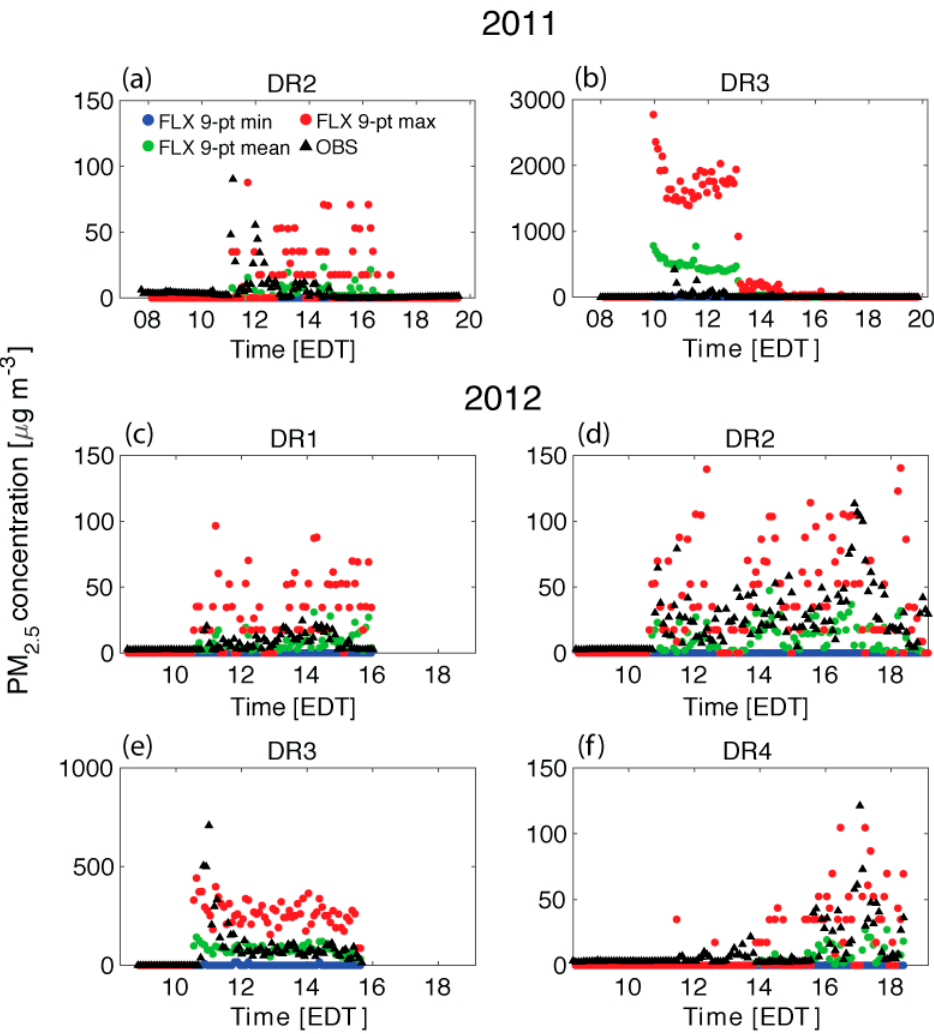
Figure 4. Time series of minimum (blue dots), maximum (red dots), mean (green dots), and observed (black triangles) PM 2.5 concentrations [µg m − 3 ] simulated by AC/F [lowest grid cell; 0–2 m AGL] and measured by the Datarams during the ( a , b ) 2011 and ( c – f ) 2012 cases (2011CL and 2012CL). For the 2011 case only time series at DR2 and DR3 are displayed because no smoke was observed at DR1 and DR4.